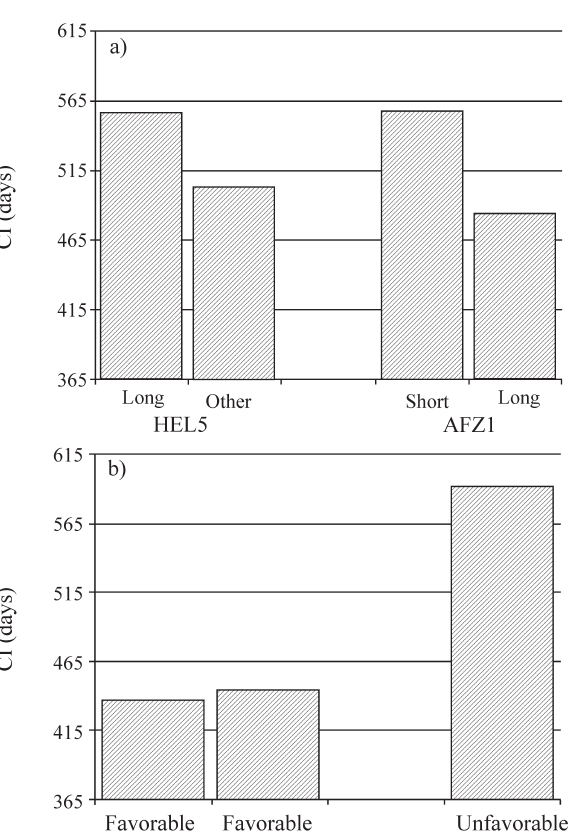
Figure 2 - Mean calving interval (CI; untransformed data) obtained from the different genotype classes of the HEL5 and AFZ1 microsatellites as- sessed independently (A). Panel B shows favorable (lower CI) and unfa- vorable (higher CI) genotypes based on the combination of results obtained from both